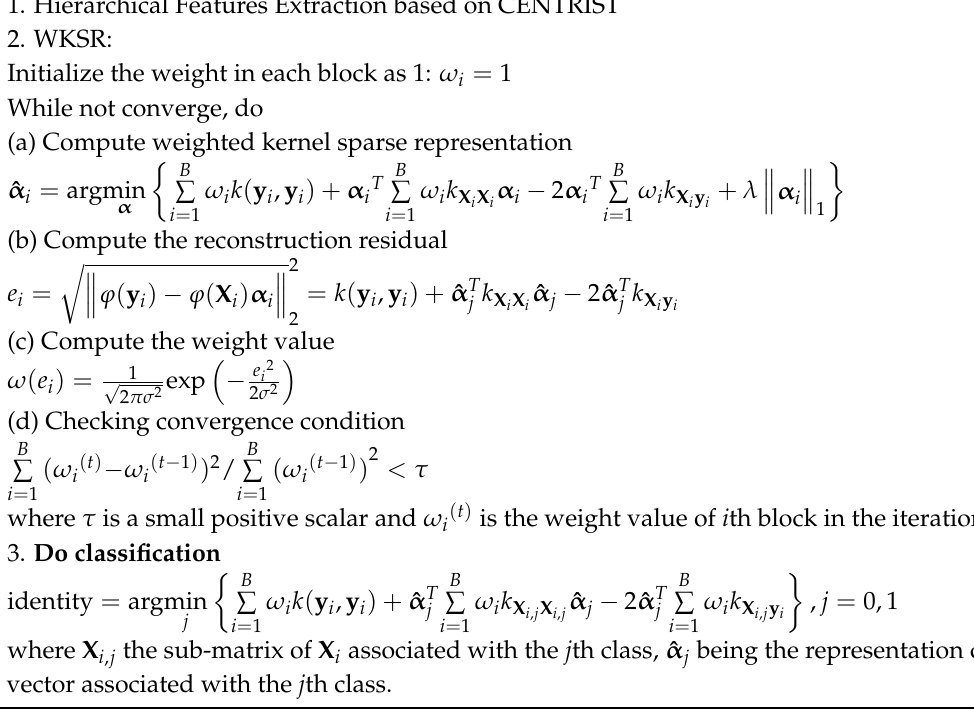
Algorithm 1: Weighted Kernel Sparse Representation